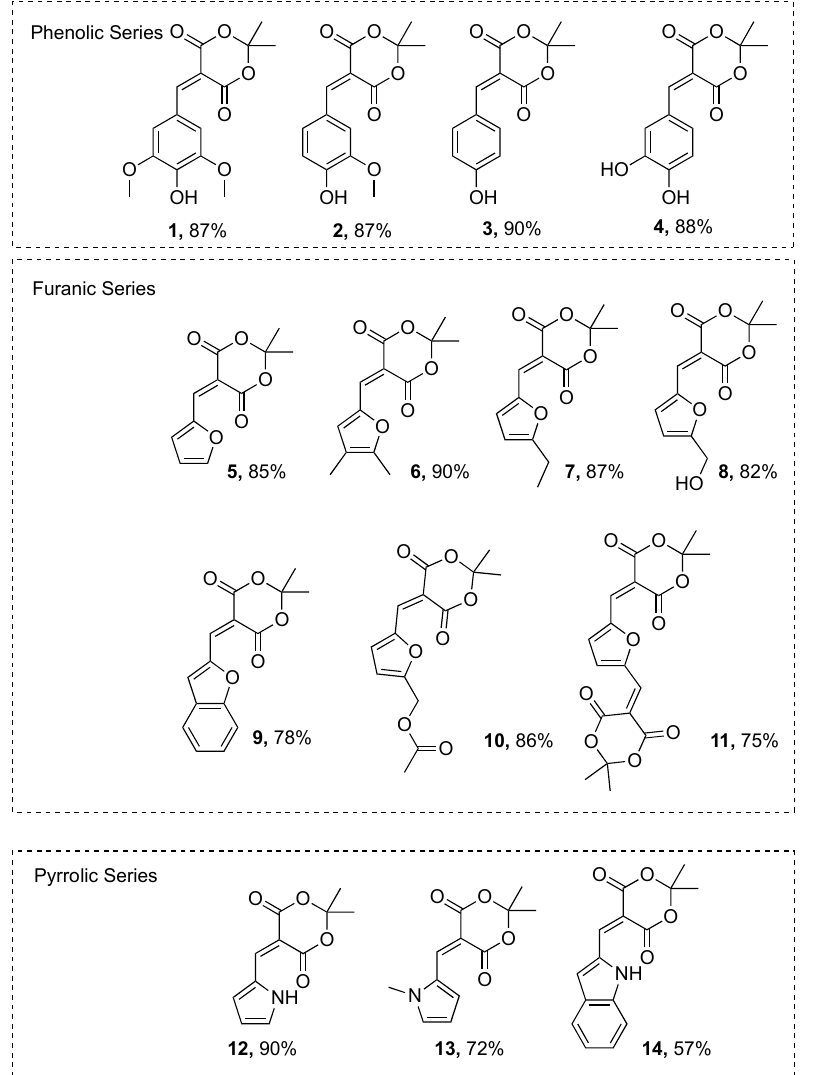
Scheme 3. Molecules resulting from the Knoevenagel reaction between Meldrum’s acid and corresponding